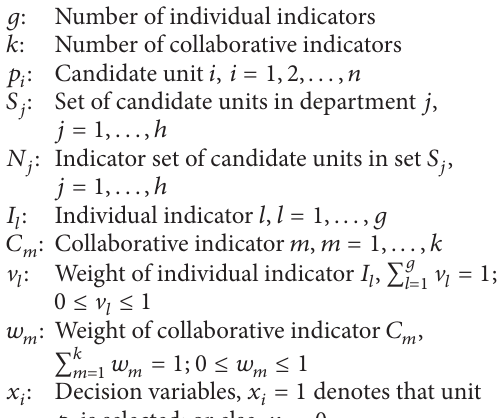
Figure 9: Case 3 : selection schemes of design units, construc- tion units, and suppliers in construction contractors under the circumstance of collaborative performance have greater weight than individual performance. Without loss of generality, we assumed 𝜆 = 0.2 , 𝜇 = 0.8 .